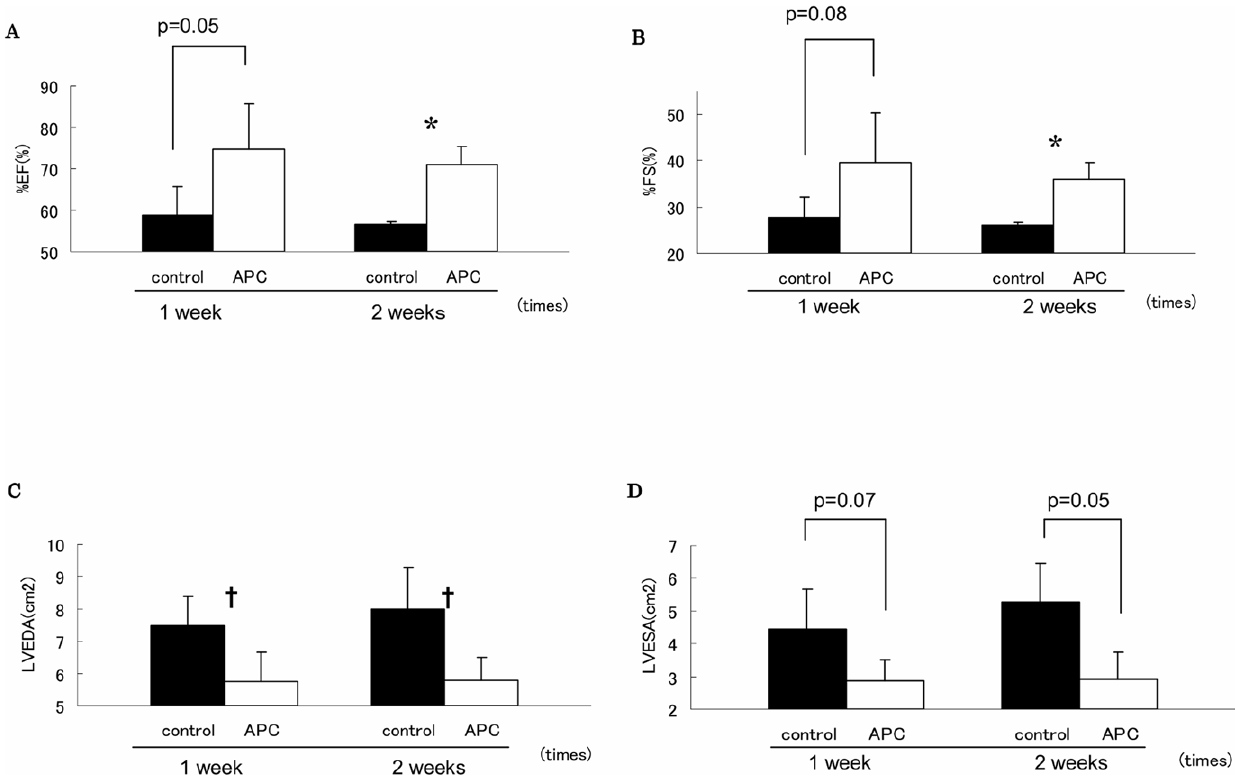
Figure 1. Assessment of cardiac performance in the regional ischemia/reperfusion injury model. We evaluated cardiac function by ultrasound cardiography at 1 and 2 weeks after the procedure in controls and the activated protein C (APC) group (n=10/group). The parameters were percent ejection fraction (EF), percent fractional shortening (FS), left ventricular end diastolic area (LVEDA) and left ventricular end systolic area (LVESA). Significant differences were observed between the two groups at 2 weeks after the procedure. Open circle indicate APC group and closed circle indicate controls. (*P , 0.05; APC group versus controls, **P , 0.01; APC group versus controls).